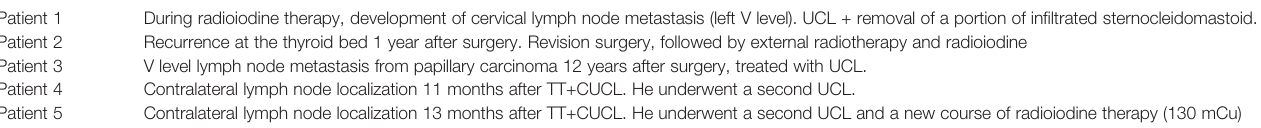
TABLE 4 | Clinical history and treatment of the fi ve relapsed patients. Patient 1 During radioiodine therapy, development of cervical lymph node metastasis (left V level). UCL + removal of a portion of in fi ltrated sternocleidomastoid. Patient 2 Recurrence at the thyroid bed 1 year after surgery. Revision surgery, followed by external radiotherapy and radioiodine Patient 3 V level lymph node metastasis from papillary carcinoma 12 years after surgery, treated with UCL. Patient 4 Contralateral lymph node localization 11 months after TT+CUCL. He underwent a second UCL. Patient 5